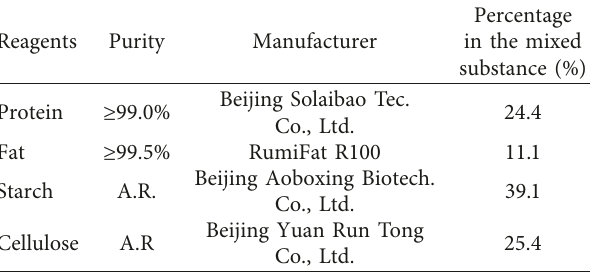
Table 1: Information of reagents and the mixed substance.